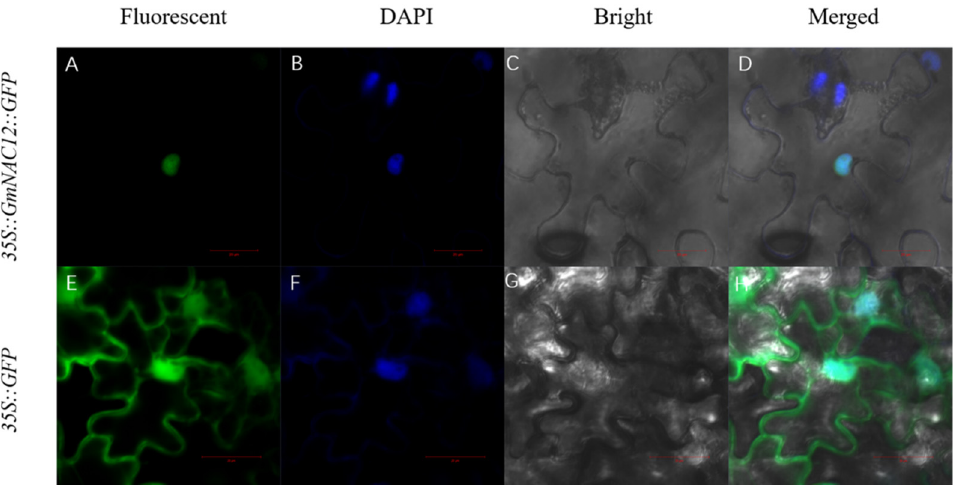
Figure 4. Subcellular localisation of GmNAC12 in a tobacco cell. ( A – D ) 35S::GmNAC12::GFP fluo- rescence images in a tobacco cell. ( E – H ) 35S::GFP fluorescence images in a tobacco cell. Nicotiana benthamiana leaves were transiently infiltrated with A. tumefaciens EHA105-containing vector ex- pressing 35S::GFP or 35S::GmNAC12::GFP . All images were collected using the Zeiss confocal mi- croscope after agroinfiltration for 48 h. DAPI images indicate nuclear staining. Scale bars are 50 µm.